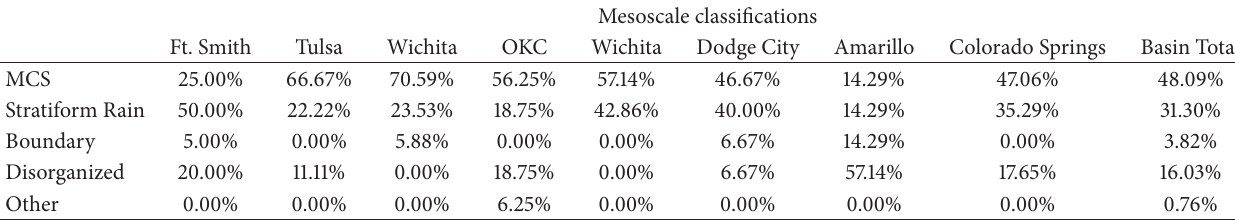
Table 6: Percentage of event per mesoscale classification by location.